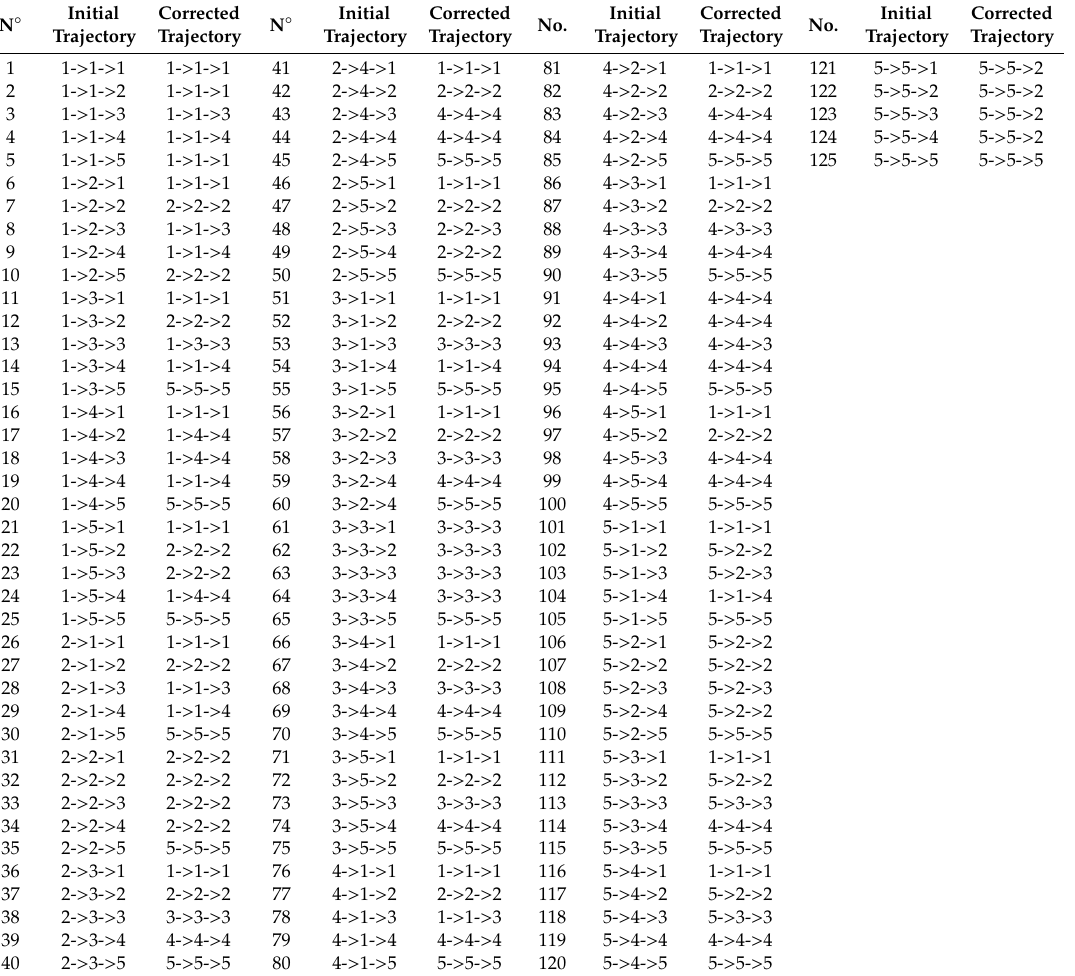
Table 4. Unique pixel temporal trajectories for the di ff erent LULC classes and suggested correction. N ◦